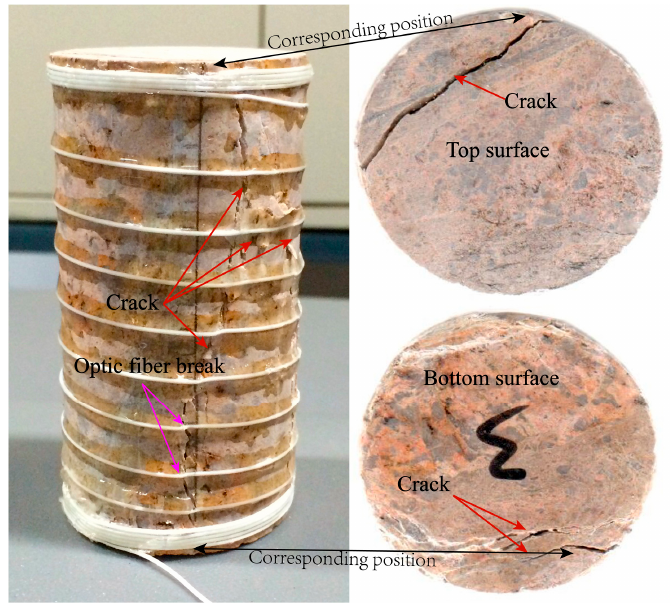
Figure 11. Fracture surface damage characteristics of No.3 rock